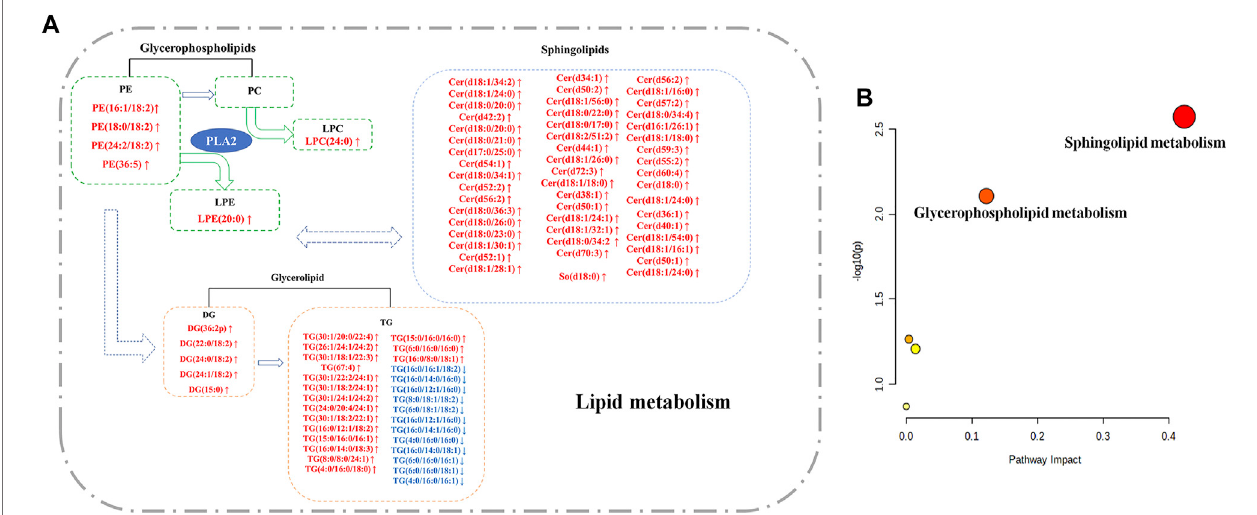
FIGURE 8 | Lipid metabolic pathway analysis of identi fi ed differential lipid species. (A) The network of potential biomarker variation in M rats compared to C rats in Lipid Metabolism. Red ( ↑ ): upregulation; Blue ( ↓ ): downregulation. (B) The Metabolomics Pathway Analysis identi fi ed sphingolipid metabolism, glycerophospholipid metabolism, and linoleic acid metabolism from the signi fi cantly differential lipid species. The size and color of each circle are based on pathway impact values and p -values, respectively.